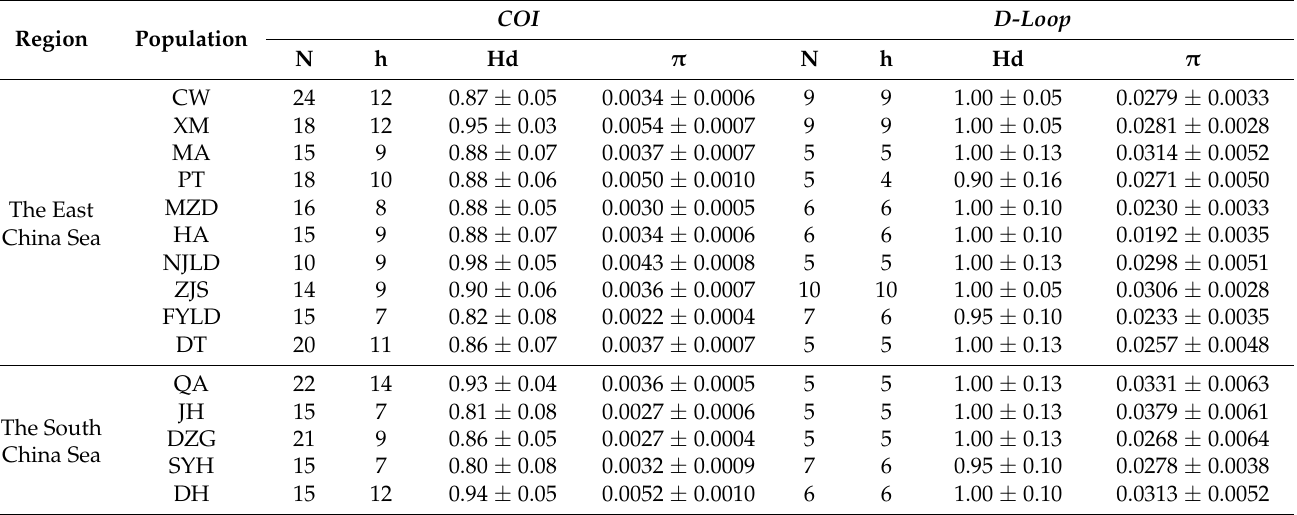
Table 2. Genetic diversity for 15 populations of horn-eyed ghost crab based on COI / D-Loop sequences. N, number of specimens for each population; h, the number of haplotypes; Hd, haplotype diversity; π , nucleotide